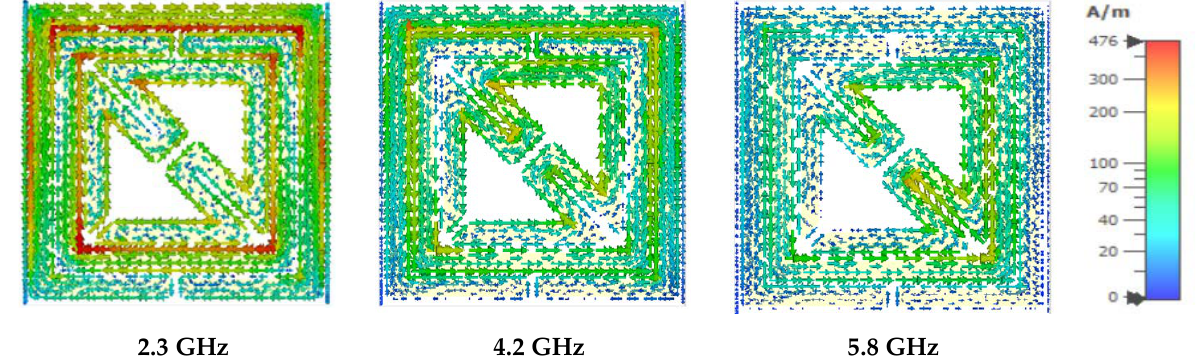
Figure 11. Surface current distribution at 2.3, 4.2, and 5.8 GHz.